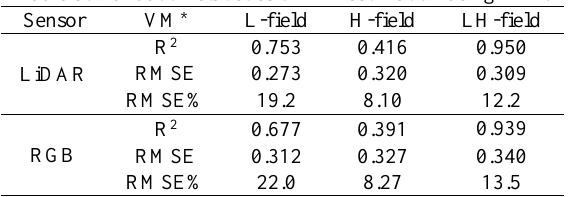
Table 3. Validation statistics of LAI estimation using RFR.